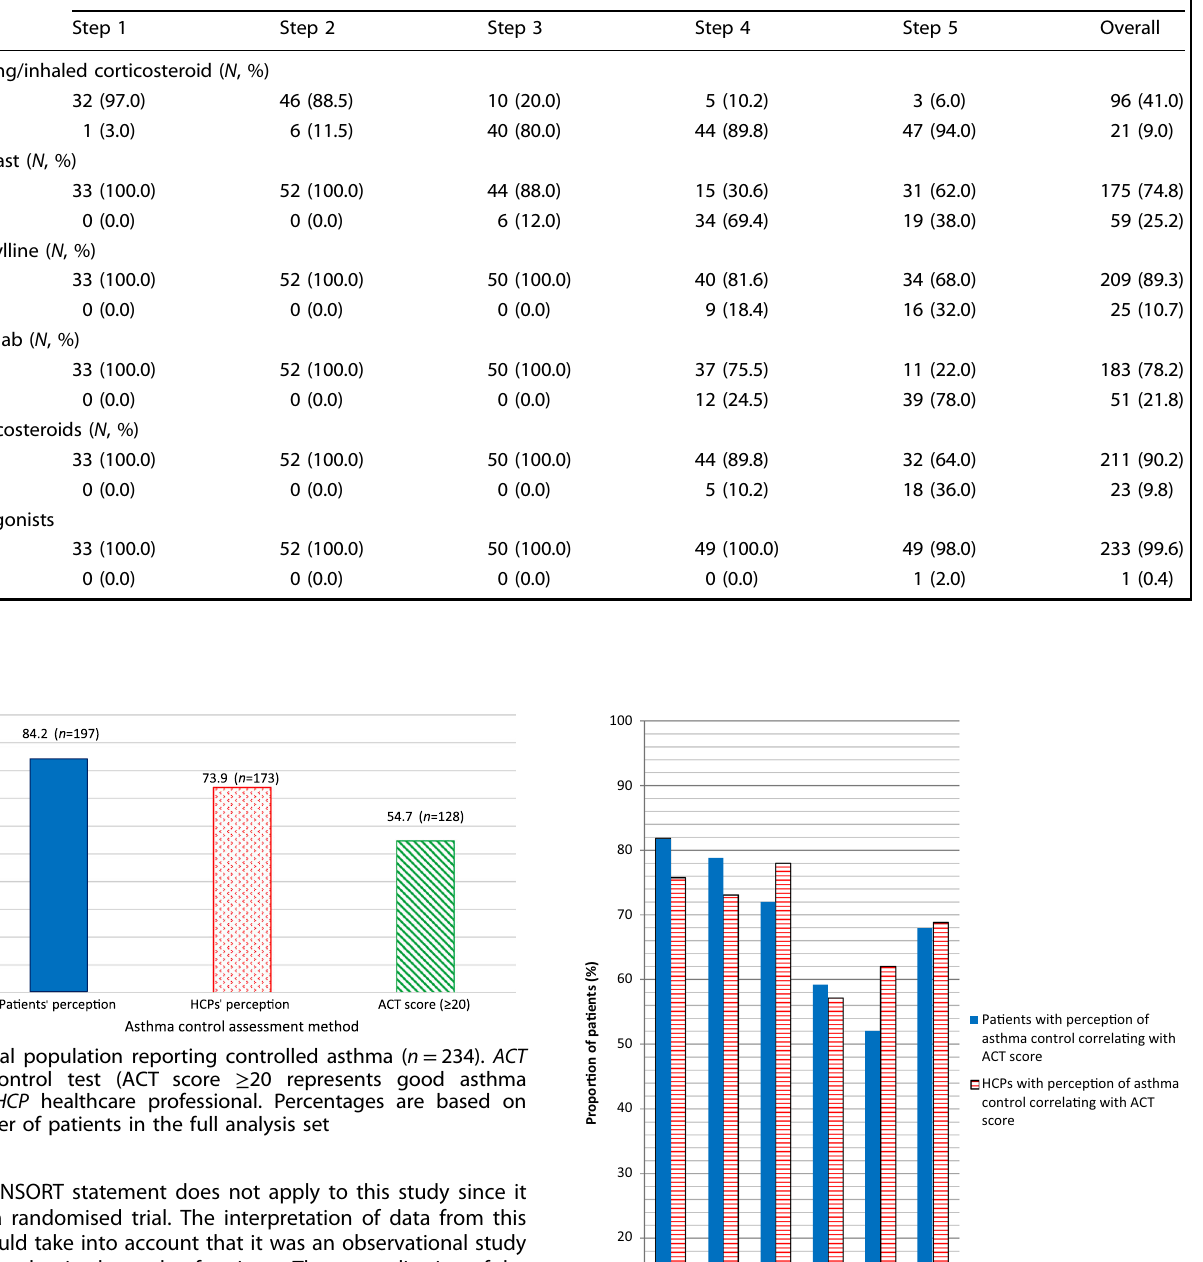
Table 2. Medications taken at baseline BTS/SIGN Step (2014 guidelines)